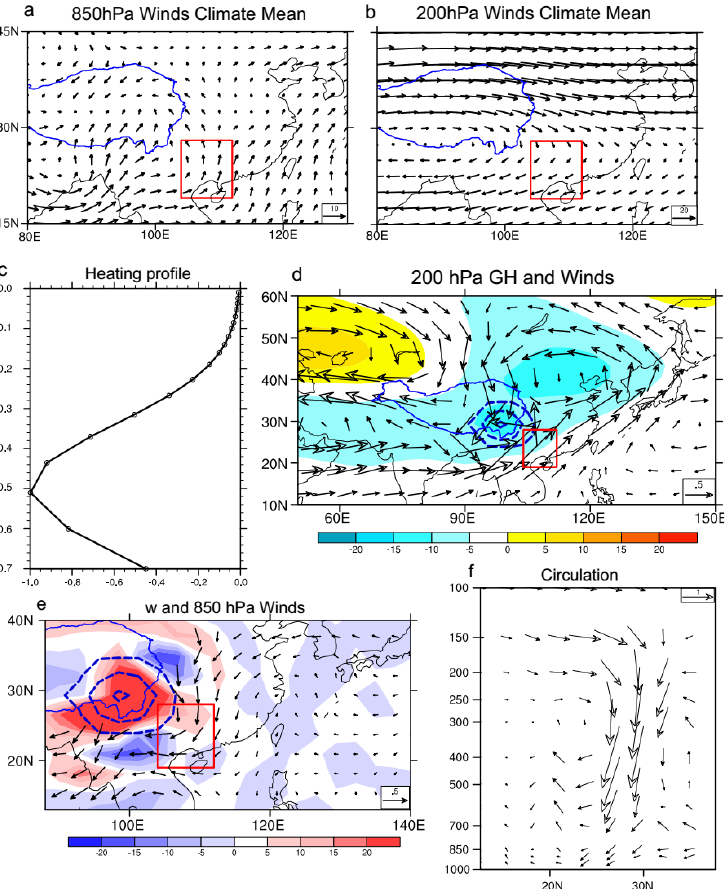
Figure 5. Spatial patterns of climatological mean 850 hPa winds ( a ) and 200 hPa winds ( b ) during boreal summer in 1979 – 2019. ( c ) Vertical profile of specific heat source (K day − 1 ). The x-axis and y-axis in ( c ) denote the magnitude of heating and height represented by sigma, respectively. ( d ) The responses of winds and GH at 200 hPa to cooling over the southeast TP. ( e ) The responses of 850 hPa winds and vertical p to velocity average from 500 to 850 hPa to cooling over the southeast TP. ( f ) The responses of meridional to vertical cross-section of circulation averaged over 95° E – 108° E to cooling over the southeast TP. The cooling forcing patterns (the blue dashed lines represent −4, −2.5, −1 , and −0.1 K day − 1 ) are shown in ( d , e ).